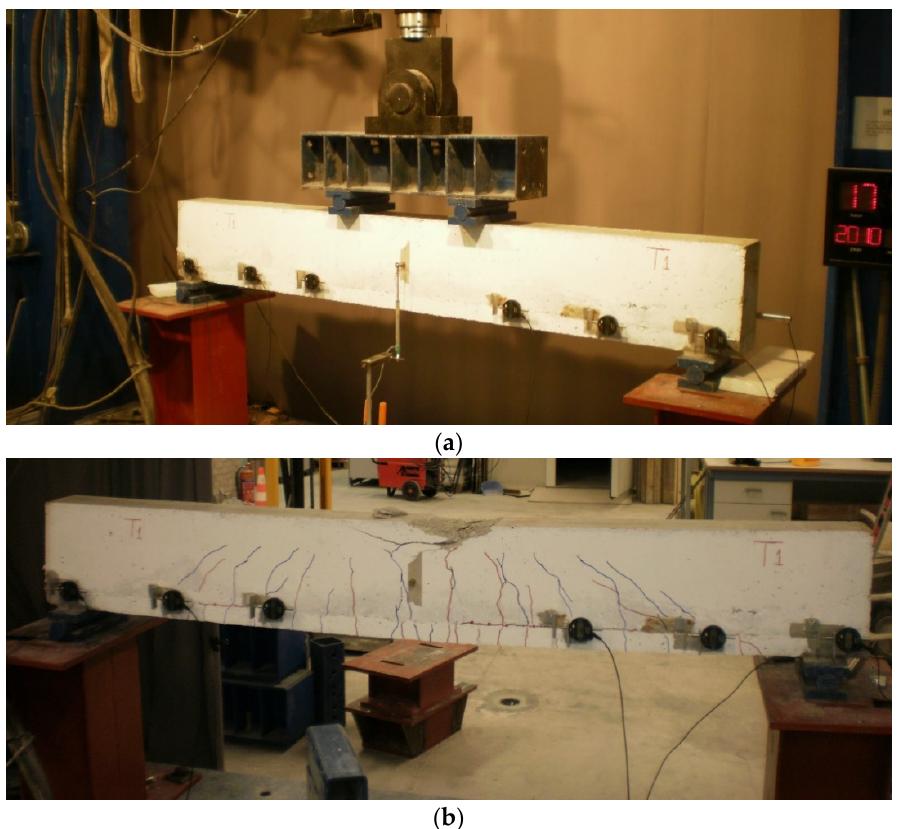
Figure 16 . ( a ) Test setup and ( b ) failure mode of the beam strengthened with conventional reinforced concrete layer.